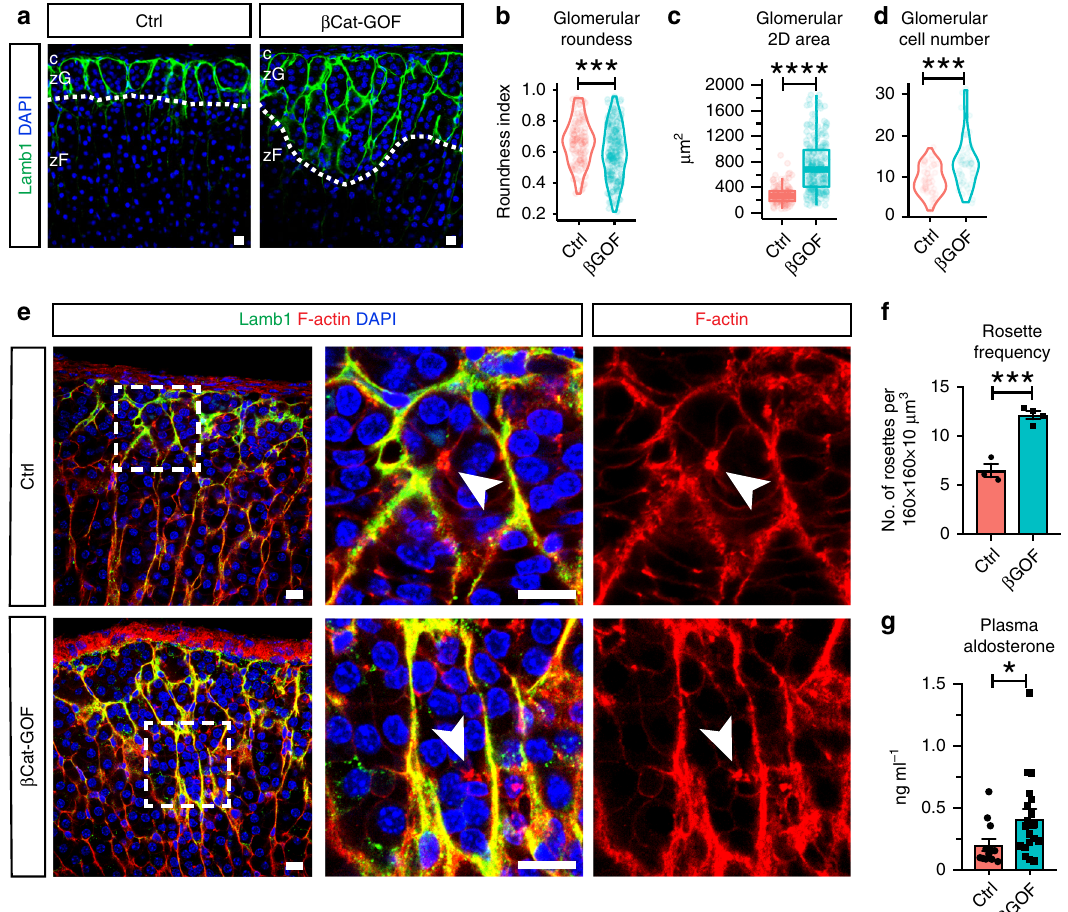
Fig. 5 β -catenin stabilization results in zG expansion and increased rosette frequency. a Lamb1 staining (green) in β -catenin gain-of-function ( β GOF) adrenals of female mice and controls (Ctrl). DAPI (blue) marks nuclei. Dotted line demarcates the zG/zF boundary. c capsule, zG zona glomerulosa, zF zona fasciculata. b , c Measurement of glomerular roundness and cross-sectional area. Mann – Whitney ’ s non-parametric test, *** P < 0.001; **** P < 0.0001. Three animals from each group and at least 30 glomeruli per animal were examined. d Measurement of glomerular cell number. Mann – Whitney ’ s nonparametric test, *** P < 0.001. Three mice per group and at least ten glomeruli per mouse were counted. e F-actin staining (red) shows rosettes in expanded zG of β Cat-GOF adrenals in females. Lamb1 (green) outlines glomerular boundary. DAPI (blue) marks nuclei. Boxed areas are shown in higher magni fi cation on the right. Arrowheads point to rosette centers. f Rosette frequency calculated as rosette number per 160 × 160 × 10 μ m 3 z-stack cortical area. Student ’ s t test, *** P < 0.001, N = 3, 4 mice. For each animal, data from three different cortical areas were averaged. g Plasma aldosterone levels are elevated in female β Cat-GOF mice compared to controls. Mann – Whitney ’ s nonparametric test, * P < 0.05, N = 13, 19 mice. All bars, 10 μ m. In all bar plots, error bars represent SEM. In all box plots, box boundaries represent the 25th and 75th percentiles, whiskers represent the 5th and 95th percentiles, center lines represent median. Source data are provided as a Source Data fi